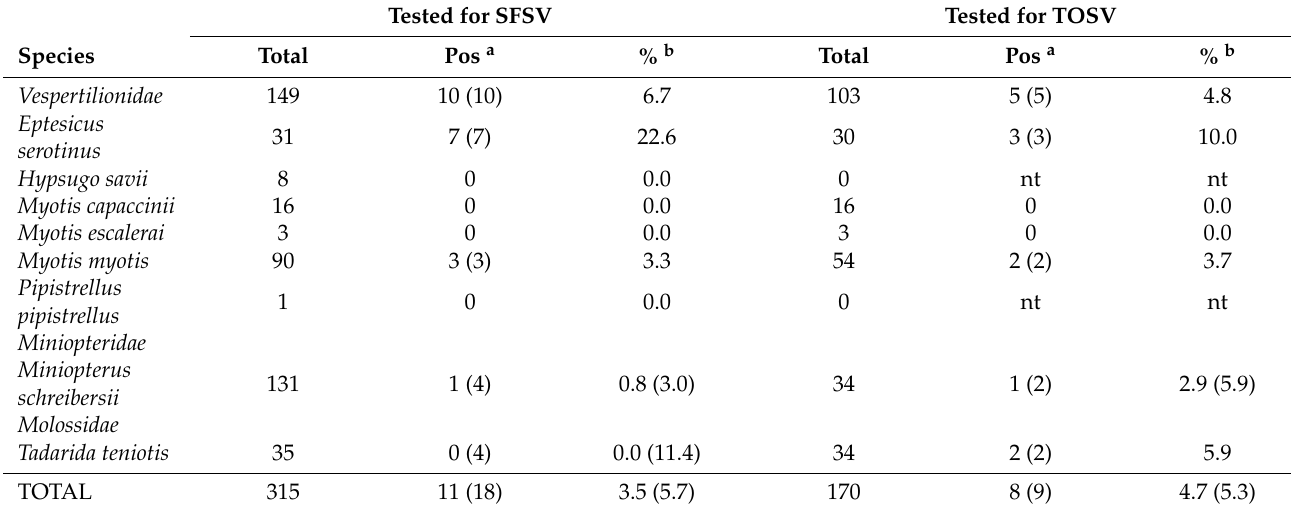
Figure 1. Map of north-eastern Spain showing the sampled localities. Blue circles indicate localities where TOSV-seropositive bats were found. Red circles indicate localities where TOSV- and SFSV- seropositive bats were found. Black circles correspond to localities where all samples were negative. 2.2. Detection of Neutralizing Antibodies Against TOSV and SFSV Each serum was analyzed for SFSV-NT-Abs first, and then for TOSV-NT-Abs if the Table 1. Distribution of tested specimens per bat species and presence of neutralizing antibodies against SFSV and TOSV. sample volume was sufficient. The virus microneutralization (MN) assay of this study was adapted from the protocol described previously [9]. Sera were tested in parallel for Tested for SFSV Tested for TOSV (strain MRS2010–4319501) and SFSV (strain Sabin). Sera were heat-inactivated at 56 °C for 30 min. The MN assay was performed in 96-well microtiter plates using Vero cells.